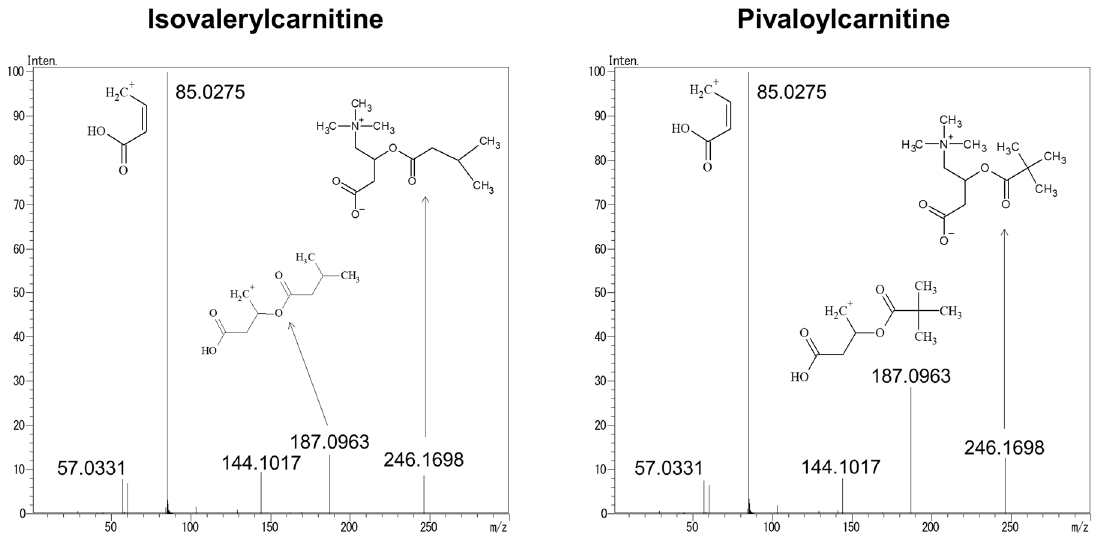
Figure 4. Product ion spectra of i-C5 and p-C5 using LC–QTOFMS.